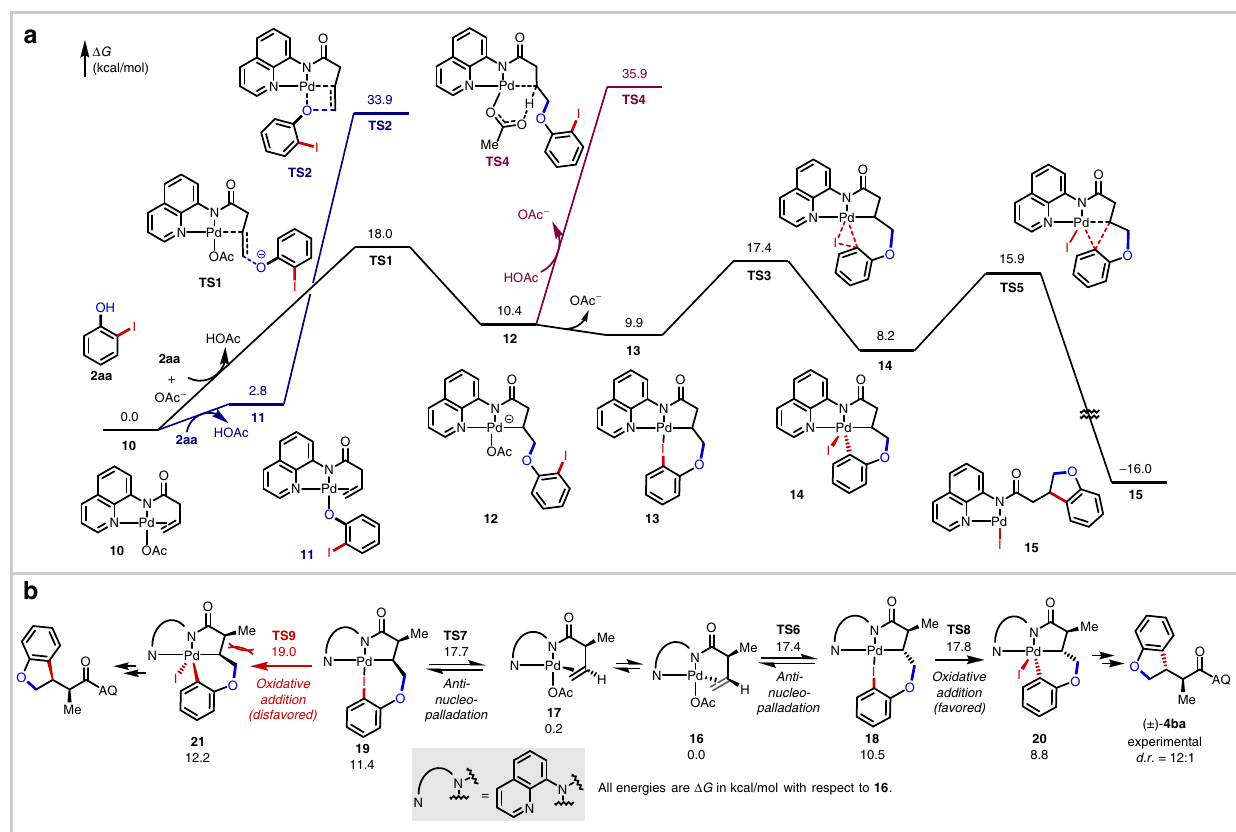
Fig. 3 Computational studies. a Computed energy pro fi les of the Pd-catalyzed [3 + 2] heteroannulation of 1a and 2aa . Calculations were performed using Gaussian 16 at the M06/SDD-6-311 ++ G(d,p)/SMD(HFIP)//B3LYP-D3/SDD-6-31G(d) level of theory. b DFT calculations on the origin of diastereoselectivity with alkene 1b